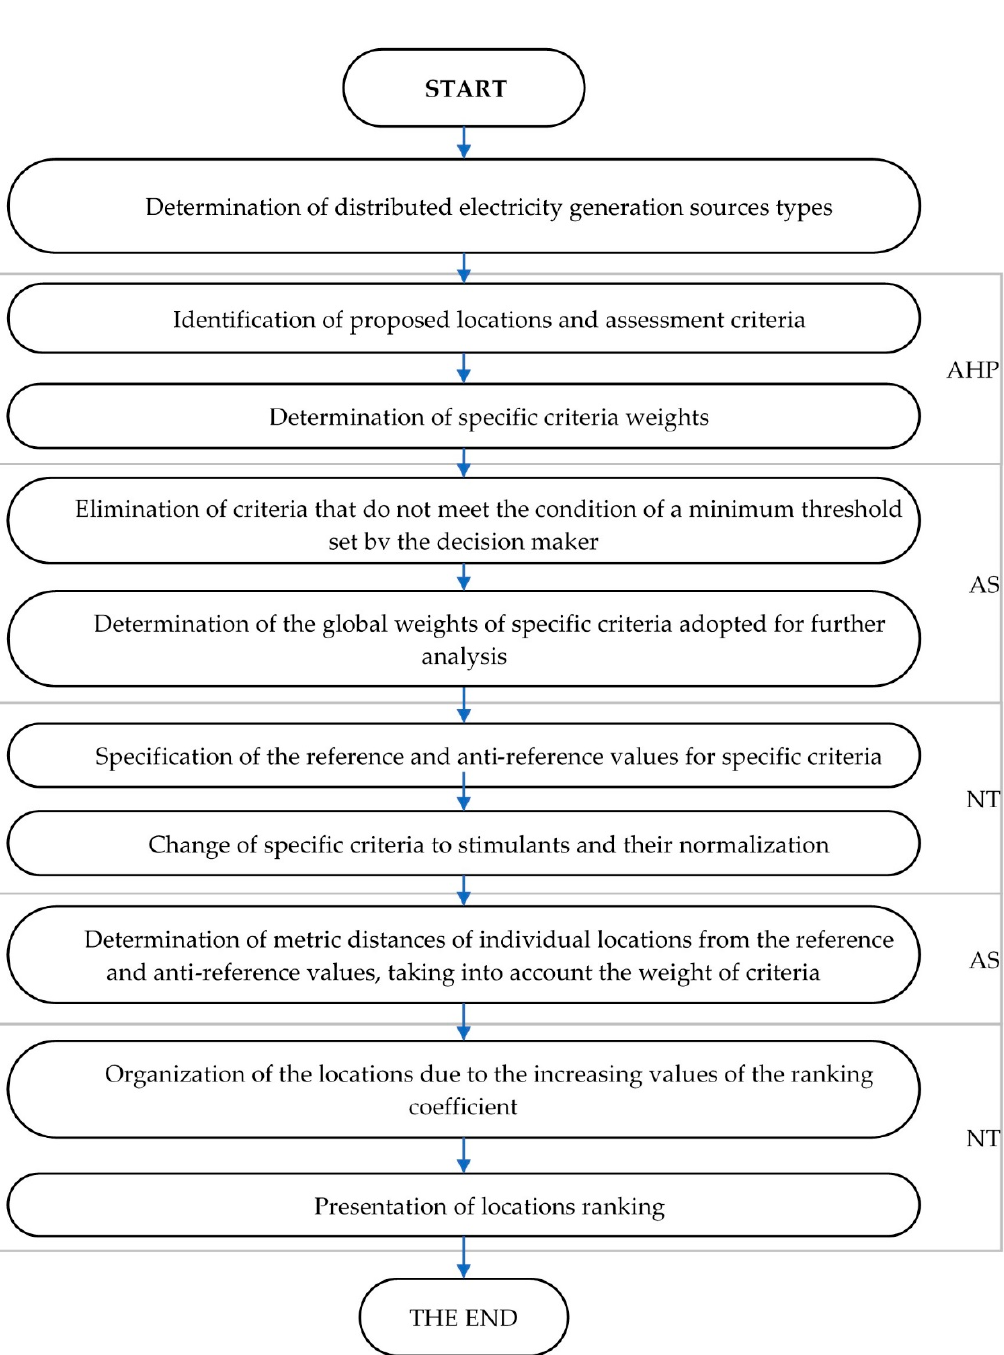
Figure 1. Method flowchart.